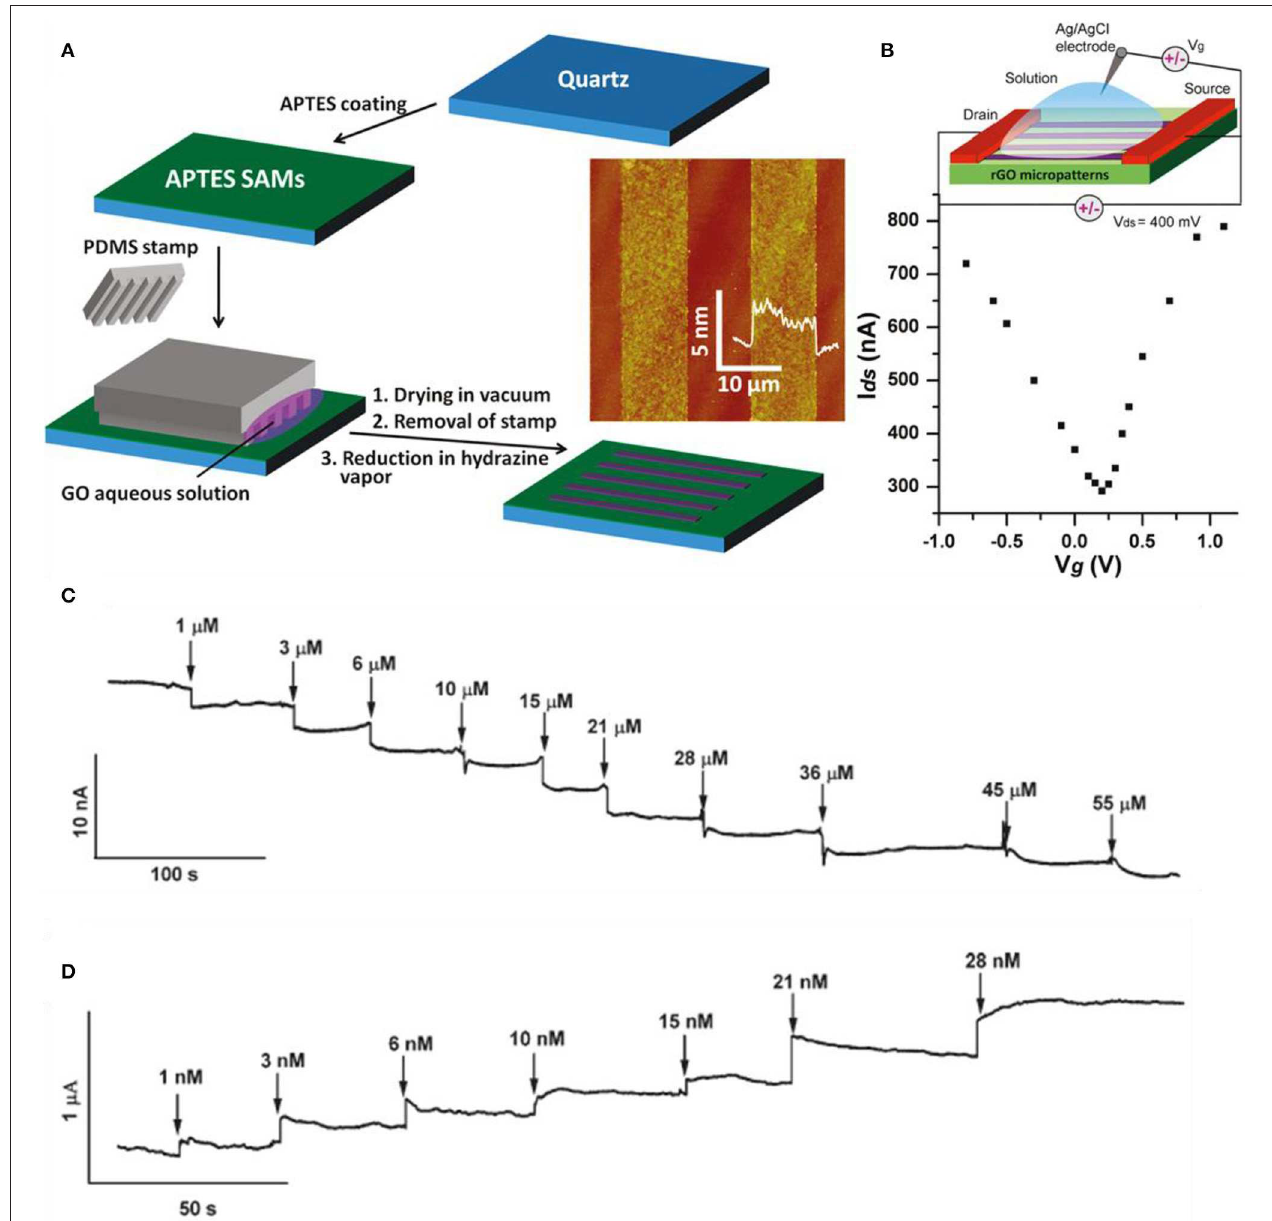
FIGURE 7 | Graphene-based FET metal ion sensors. (A) Fabrication process of RGO thin films on 3-aminopropyltriethoxysilane (APTES)-modified quartz. (B) I DS - V g curve at 0.1M phosphate buffer solution of RGO FET. Inset: Schematic diagram of overall RGO FET. (C) Real-time sensing curves with various concentrations of Ca 2 + ions. (D) Real-time sensing curves with various concentrations of Hg 2 + ions. Figures (A–D) were reproduced from Sudibya et al. (2011) with permission from the American Chemical